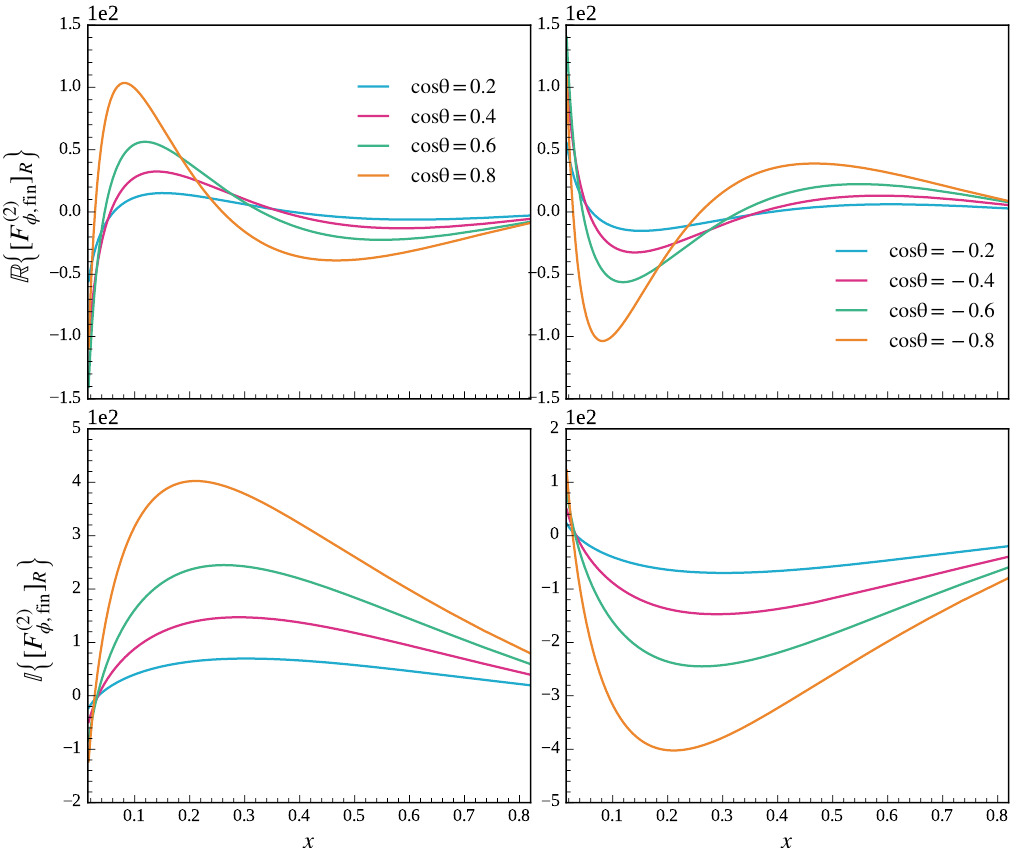
Figure 4. Behaviour of real (upper panel) and imaginary parts (lower panel) of two-loop UV renormalised finite remainder function of the scaling variable x for positive (left panel) and negative (right panel) values of cos( θ )